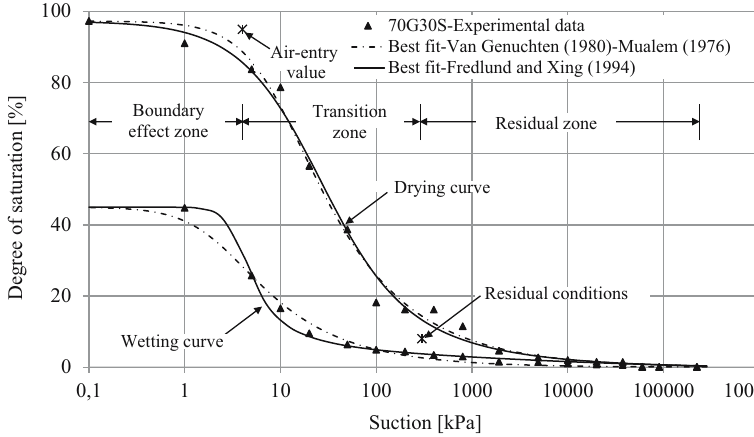
Figure 8: Soil – water characteristic SWCC, degree of saturation versus suction for 70G30S